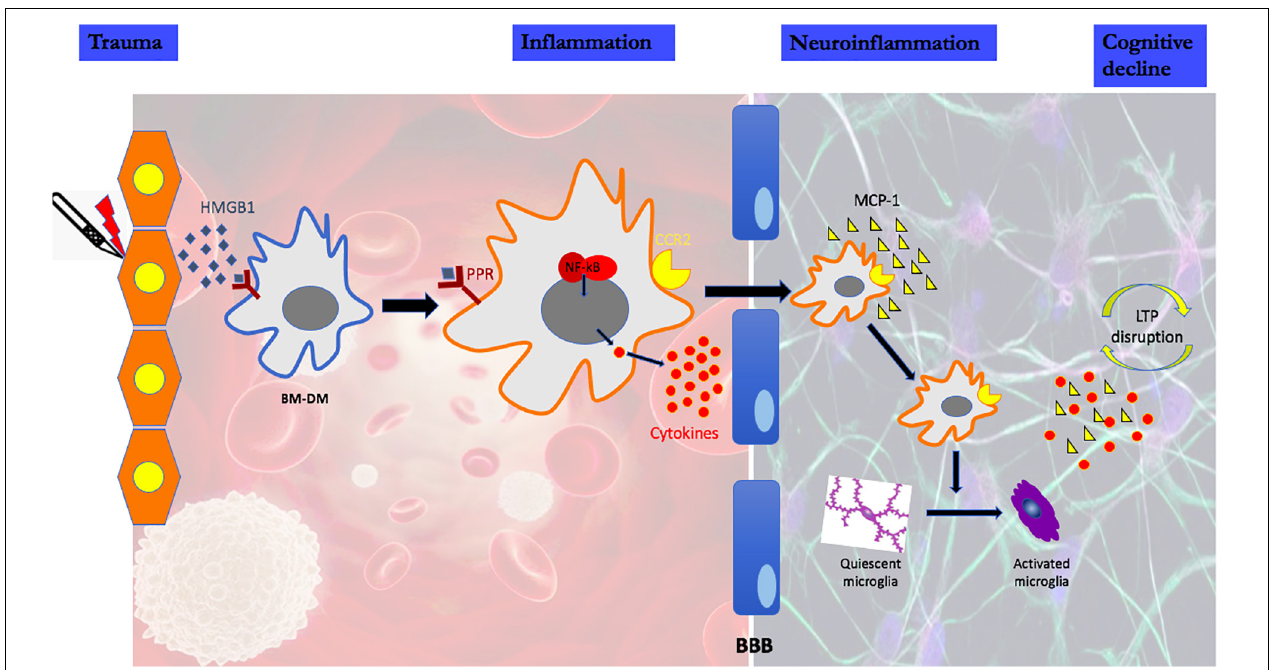
FIGURE 1 | High mobility group protein B1 (HMGB1) is a damage-associated molecular pattern that is immediately released following peripheral trauma. HMGB1 engages the innate immune response by binding to pattern recognition receptors (PRR) on circulating bone marrow-derived monocytes (BM-DMs). Signaling through the PRR results in the disaggregation and intracellular translocation of the transcription factor, nuclear factor k B (NF-kB) which increases the synthesis and release into the circulation of pro-inflammatory cytokines. High cytokine levels disrupt the Blood Brain Barrier (BBB) facilitating the translocation of circulating BM-DMs into brain attracted by the chemokine monocyte chemoattractant protein-1 (MCP-1), which itself is HMGB1-dependent. In the presence of BM-DMs within the hippocampus, quiescent microglia become activated as evidenced by the change in morphology and the release of proinflammatory cytokines. Lon-term potentiation (LTP), a synaptic plasticity mechanism required for creating and storing memory is disrupted by the proinflammatory cytokines in the